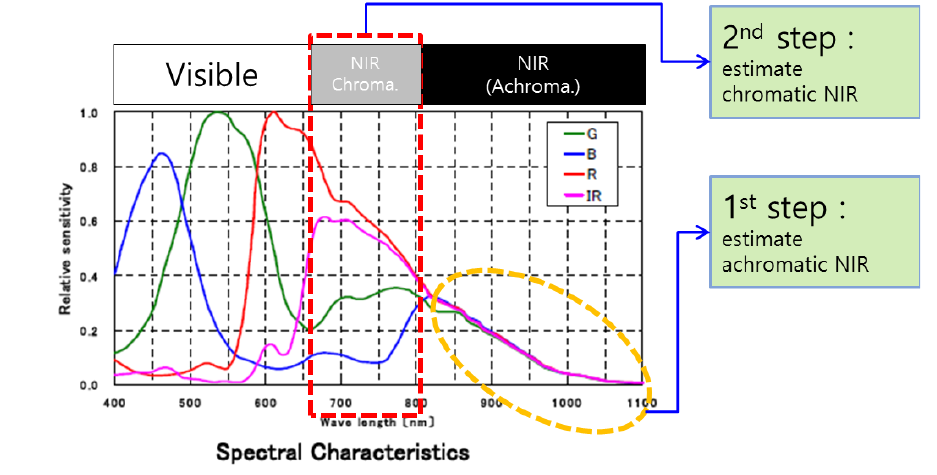
Figure 4. Spectral response of the MSFA image sensor.